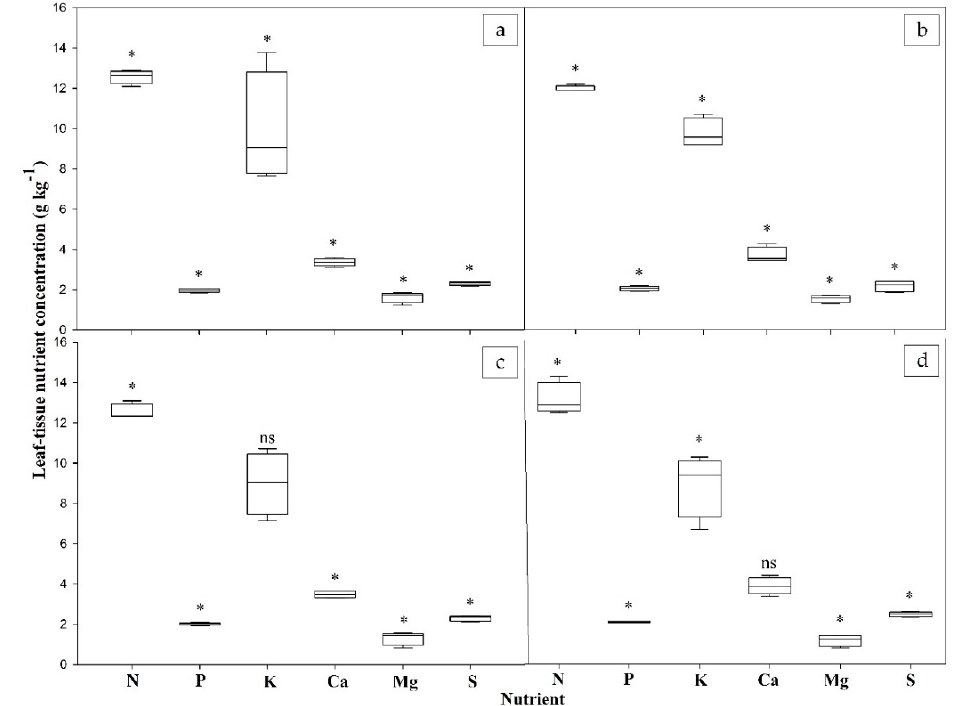
Figure 6. Leaf-tissue concentrations of N, P, K, Ca, Mg, and S in sugarcane grown under straw removal rates of 0 ( a ), 25 ( b ), 50 ( c ), and 100% ( d ) in Area 1. Shapiro–Wilk Test for normal distribution, where: * significant ( p < 0.05) and ns not significant. When significant, it indicates that the hypothesis for normal distribution is rejected.